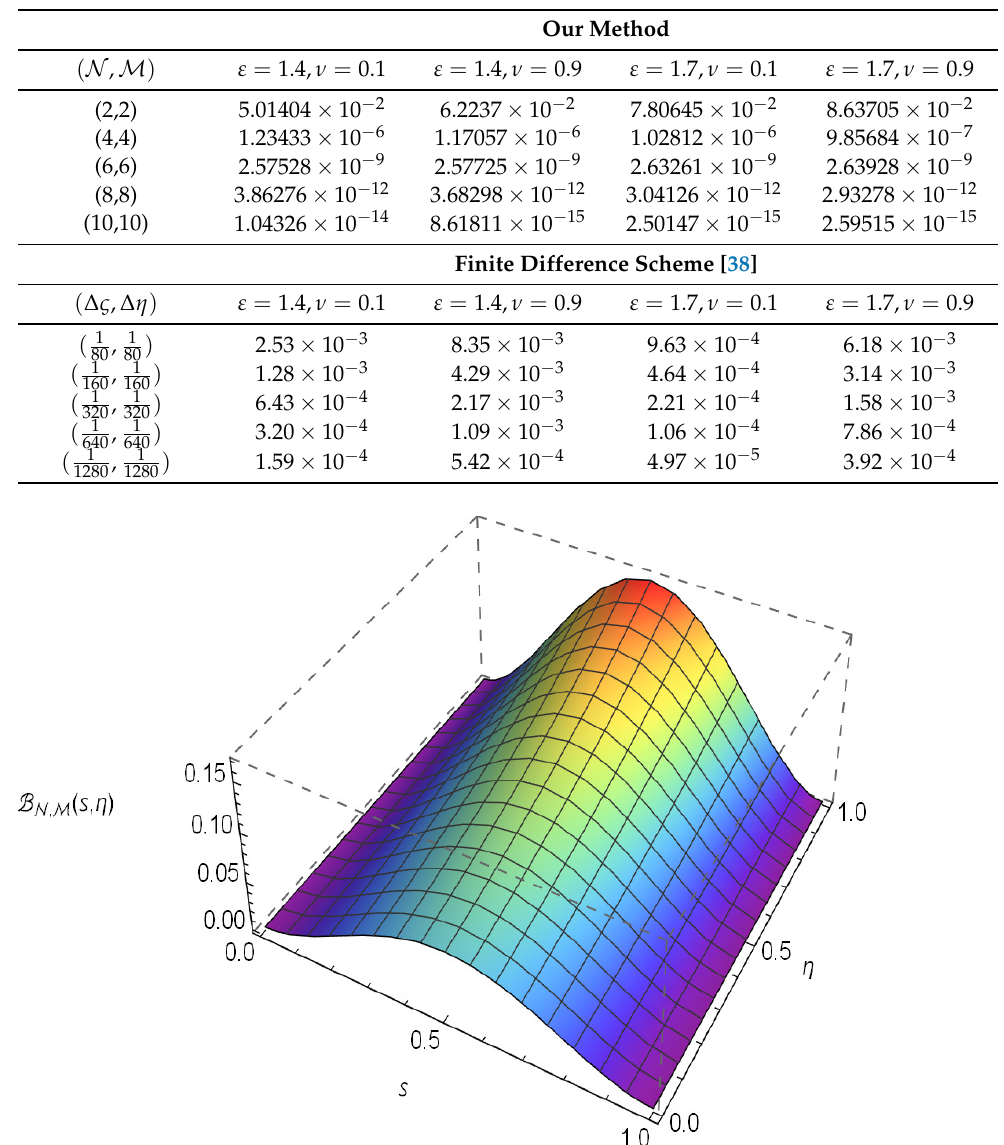
Table 1. MAEs for problem (17).